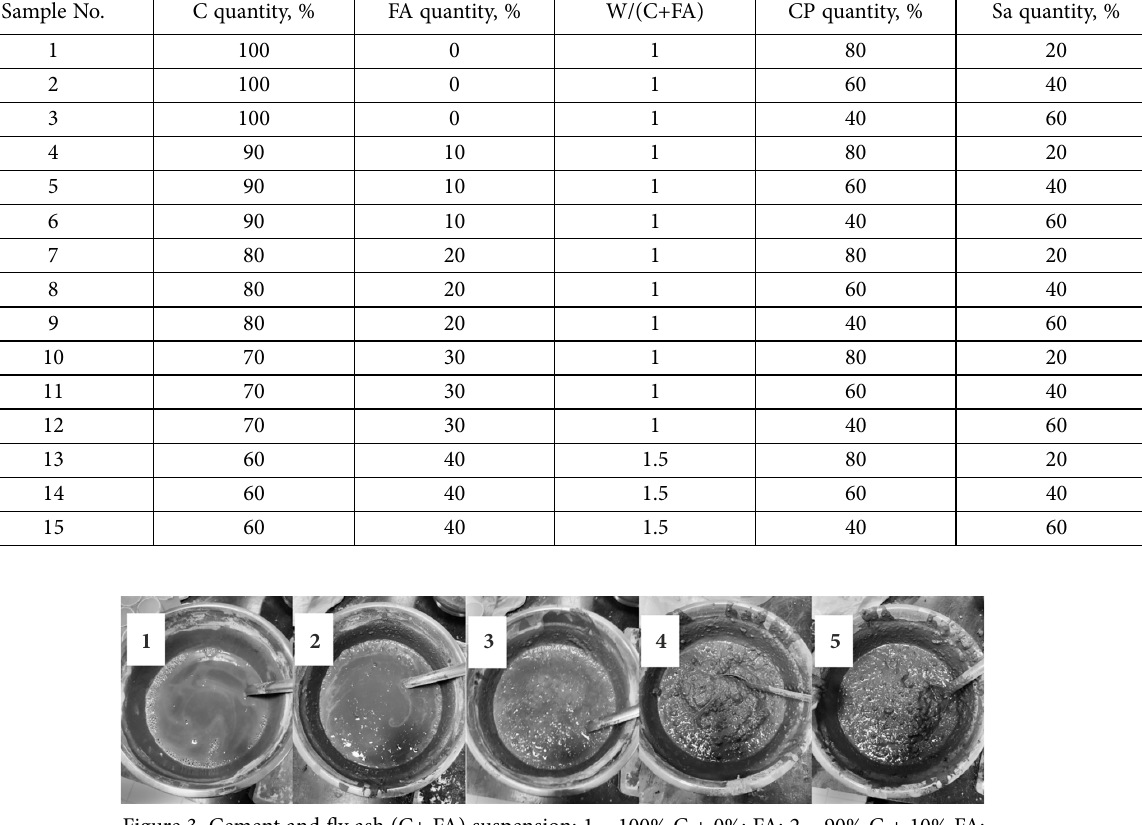
Figure 3. Cement and fly ash (C+ FA) suspension: 1 – 100% C + 0%; FA; 2 – 90% C + 10% FA;